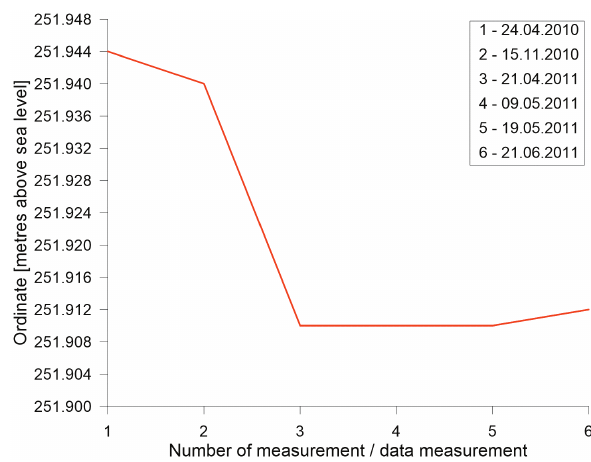
Fig. 3. Measurement point levels in the L-1 segment of the ventilation